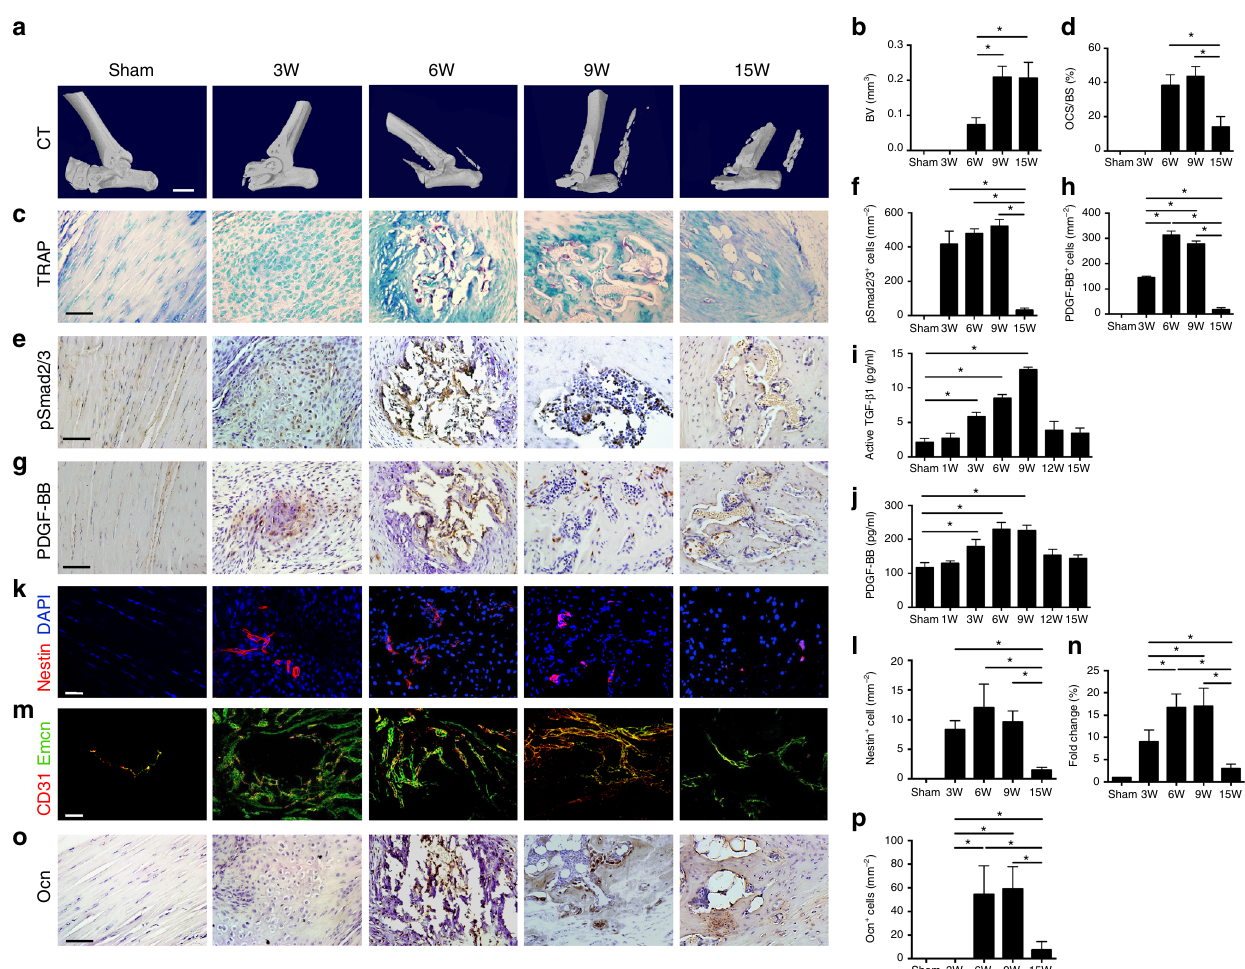
Fig. 2 Elevated active TGF- β levels were associated with increased angiogenesis in HO mice. a Micro CT images of Achilles tendon (sagittal view) after sham operation or at 3, 6, 9, and 15 weeks after ATP and b quantitative analysis. Scale bar, 2 mm. c TRAP staining (magenta) and d quanti fi cation of heterotopic bone in mouse Achilles tendon. e , g Immunohistochemical staining and f , h quanti fi cation of e , f pSmad2/3 + cells and g , h PDGF-BB + cells after sham operation or ATP. Scale bar, 50 μ m. i , j Quantitative analysis of i active TGF- β and j PDGF-BB in serum determined by ELISA. k Nestin + (red) cells in the ectopic bone marrow of sham or ATP mice and l quanti fi cation. Scale bar, 50 μ m. Blue indicates DAPI staining of nuclei. m Emcn + (green) and CD31 + (red) cells and n quanti fi cation of the fold change of type H vessels in ATP mice normalized to that of sham mice (set to 1) in the ectopic bone marrow. Scale bar, 100 μ m. Yellow indicates type H vessels. o Immunohistochemical staining and p quanti fi cation of Ocn + cells after sham operation or ATP. All data are shown as the mean ± s.d. n = 8 per group. * p < 0.05 as determined by one-way